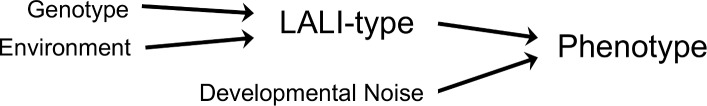
Conceptual model of the LALI-type to phenotype map.The LALI-type summarizes the genetic and environmental factors of a LALI pattern. The phenotype is a product of the LALI-type and stochastic effects (random variation called developmental noise).